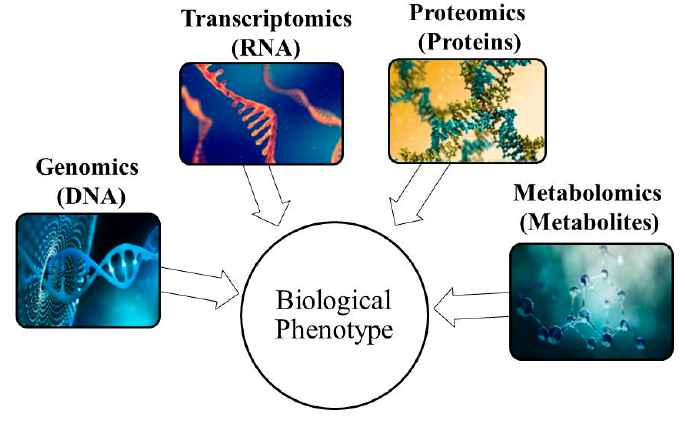
Figure 1. Omics approaches applied in the identification of the biological phenotype of various biological samples, including food commodities.